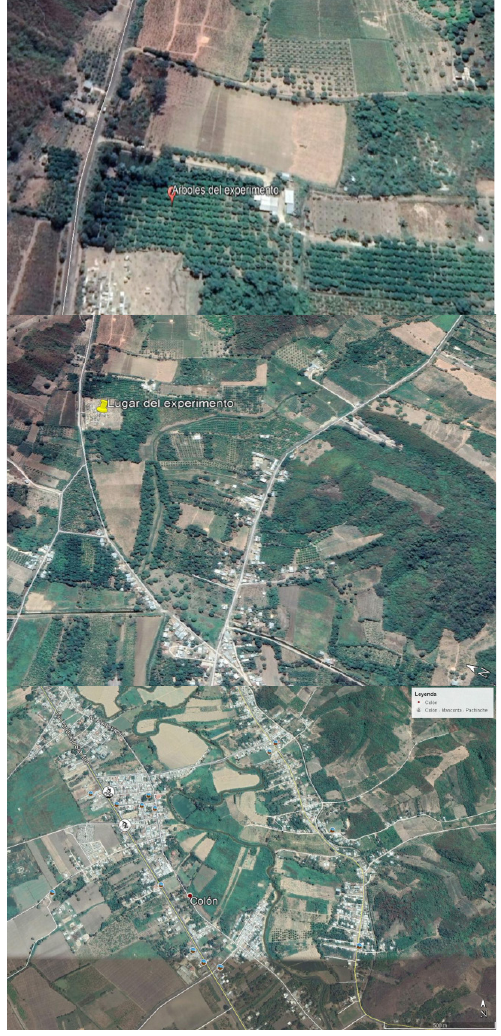
Figure 1. Study location. Source: Google Earth Ec,